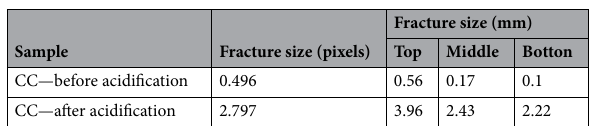
Table 5. Determination of fracture area before and after